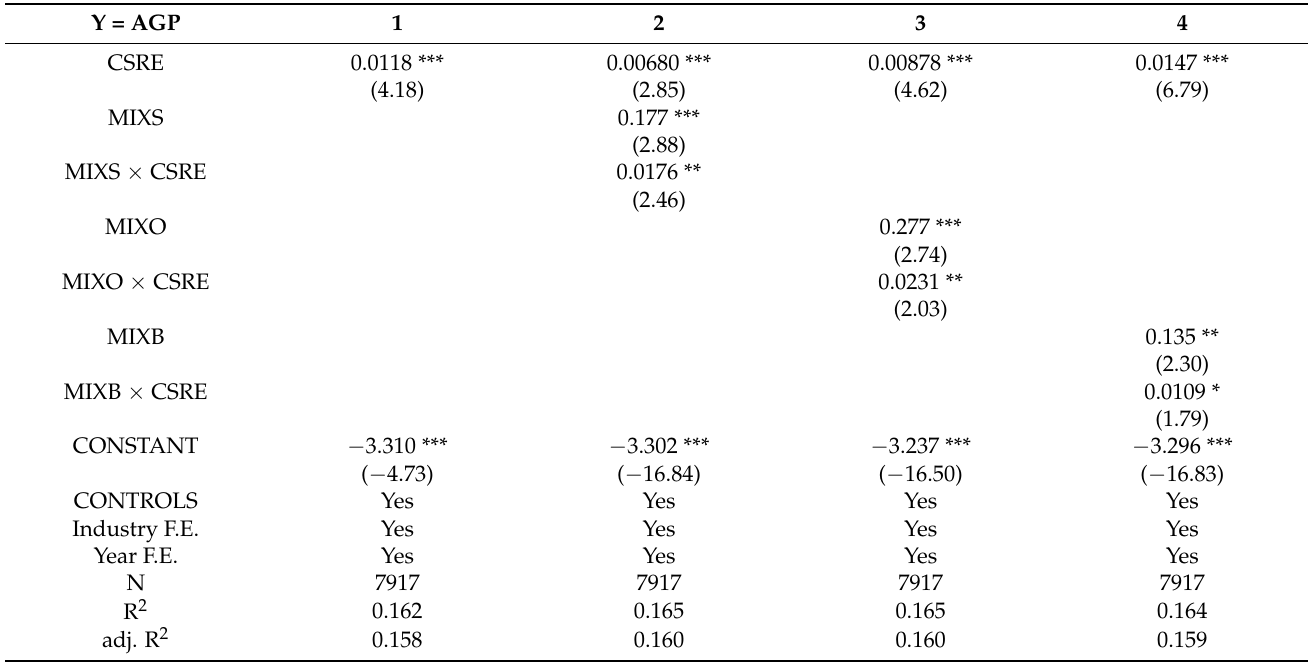
Table 10. The environmental responsibility mechanism